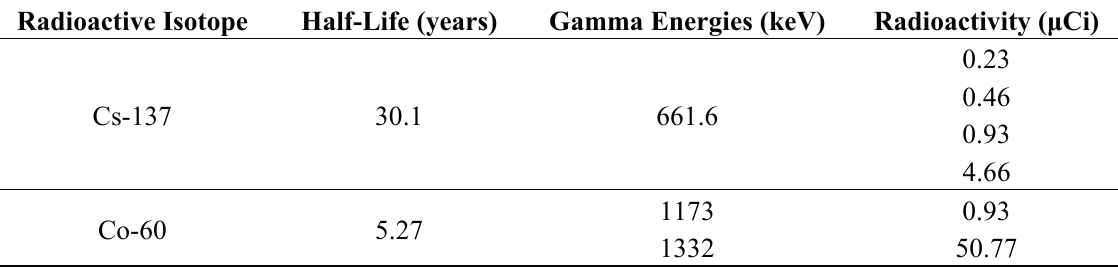
Table 2. Physical properties of two gamma-ray